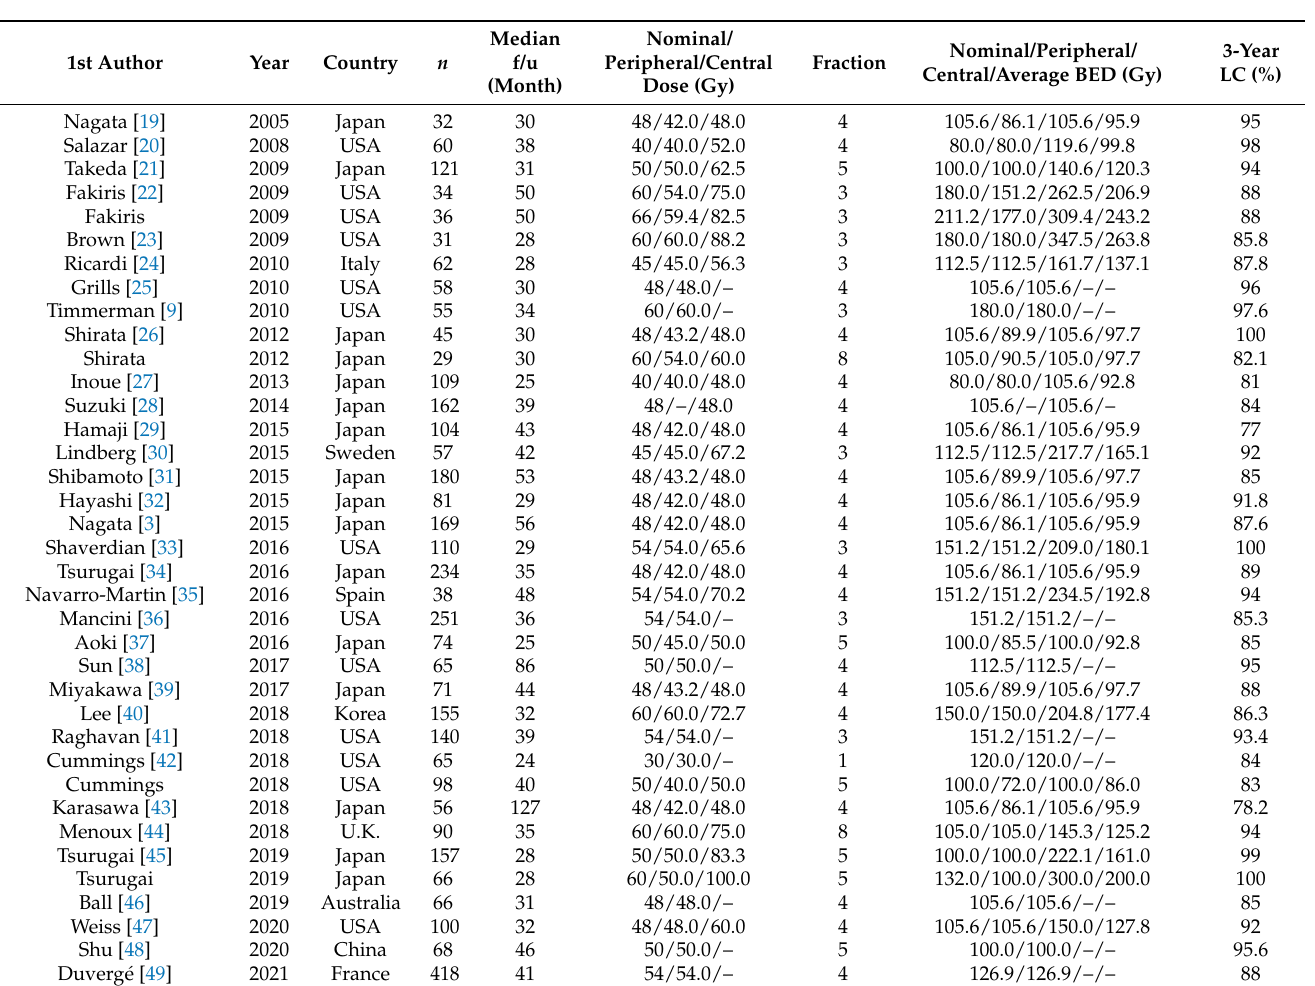
Table 1. Characteristics of included studies.